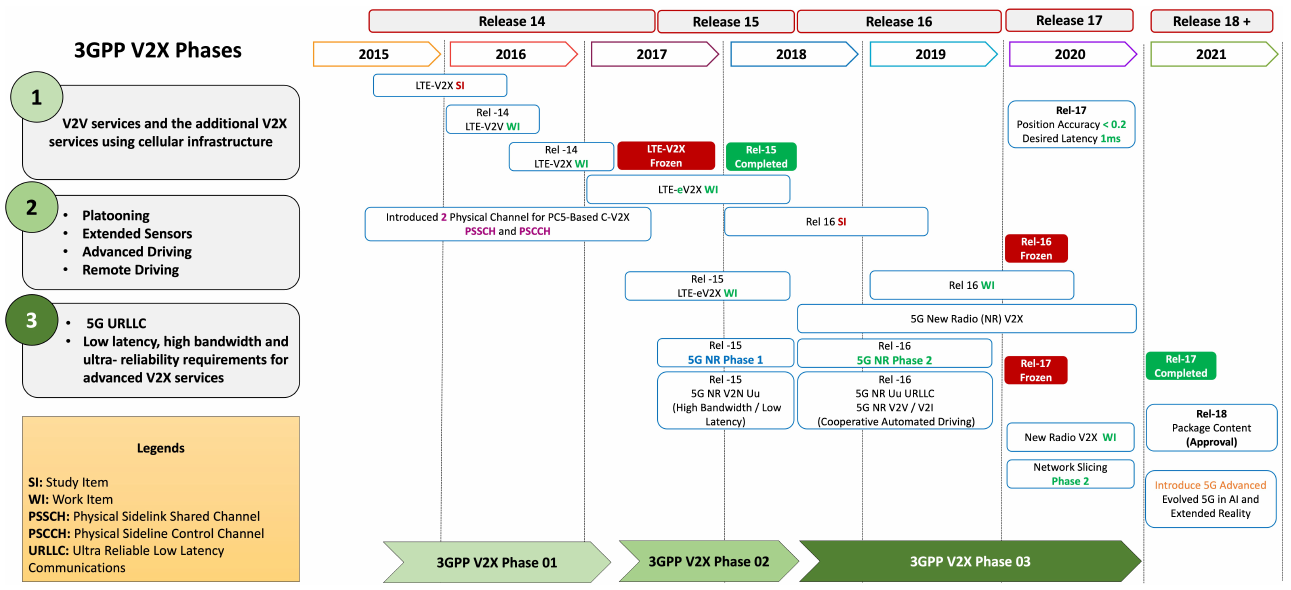
Figure 1. Evolution of 3GPP C-V2X